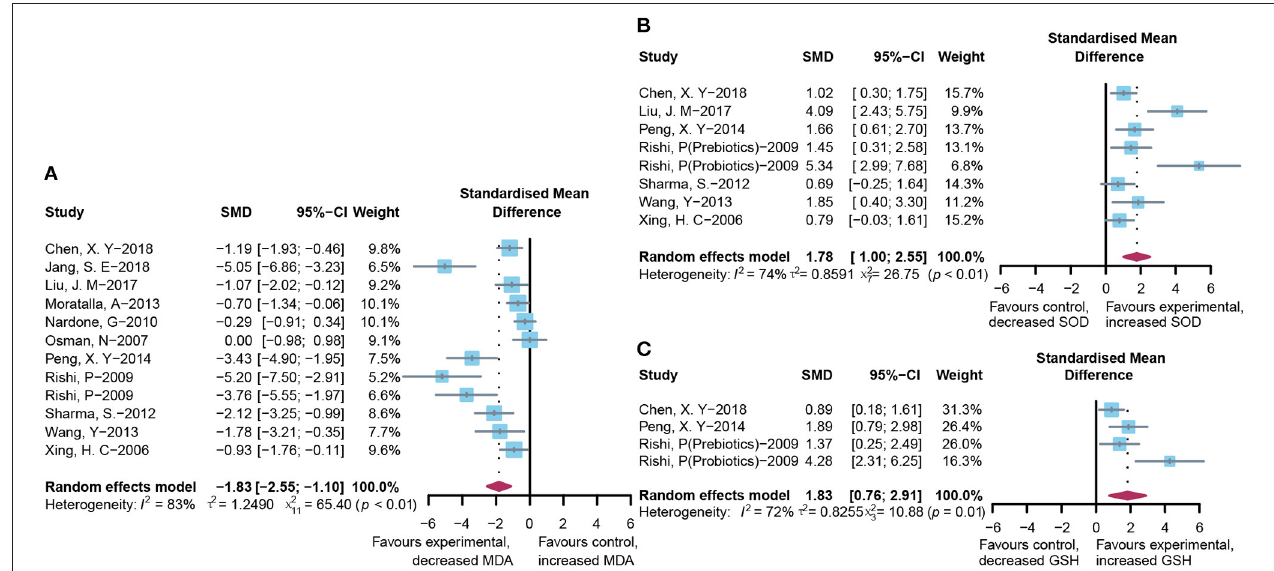
FIGURE 6 | Effectiveness of microbial agents on oxidative stress. (A) The effect of microbial agents on MDA to evaluate free radical mediated lipid peroxidation injury. (B,C) The effect of microbial agents on SOD and GSH to evaluate antioxidant status of